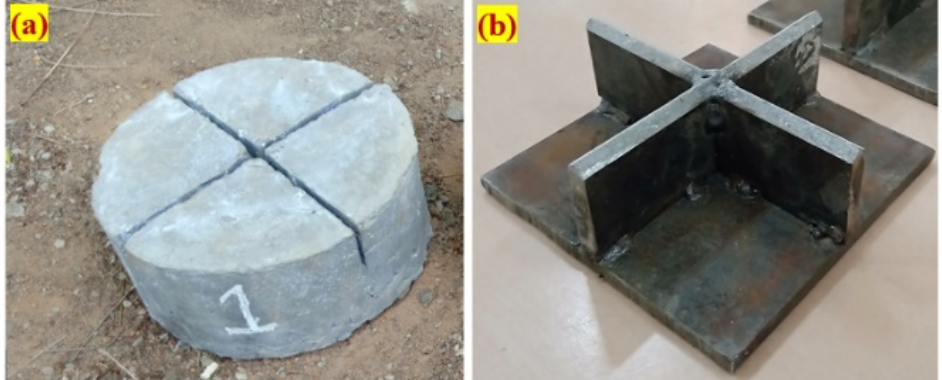
Figure 3. Details of the proposed modification: ( a ) notched specimen; ( b ) cross knifelike plate.